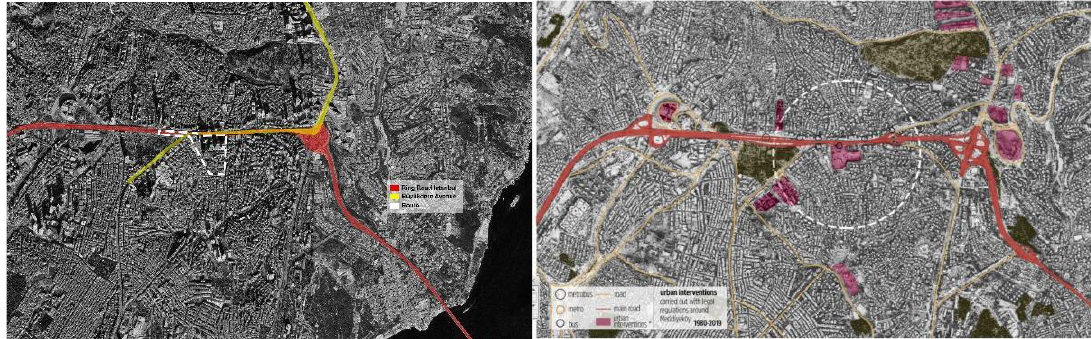
Figure 2 Mecidiyeköy’s location in Istanbul (Diagram credits: the